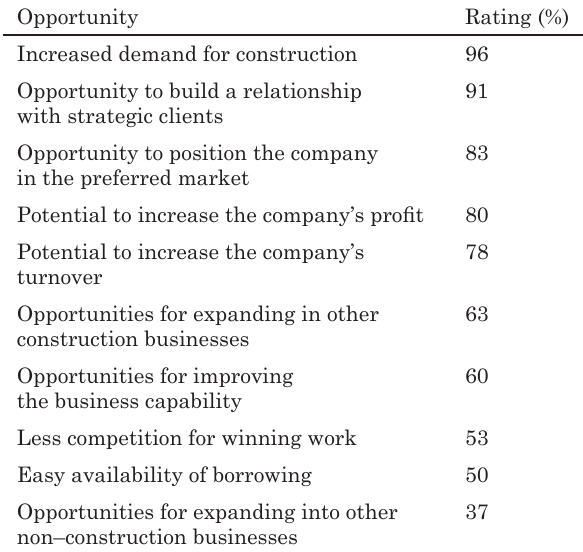
Table 2. Opportunities during the boom